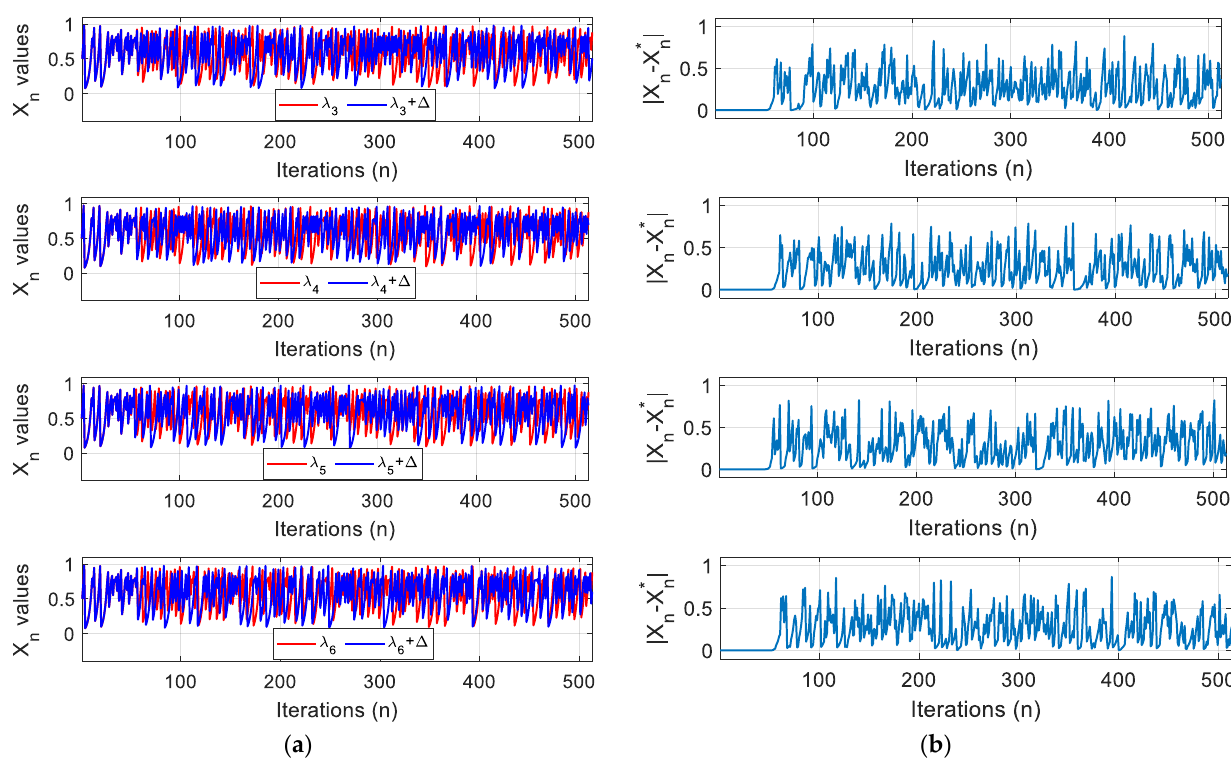
Figure 5. ( a ) Original MTM sequences (red color) and MTM sequences (blue color) generated by following a variation of its control parameters by ∆ = 10 − 13 . ( b ) The difference in absolute value between the chaotic sequences.